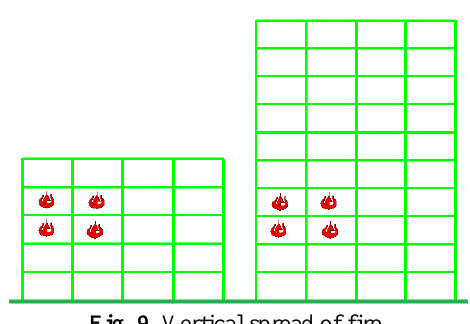
Fig. 9. Vertical spread of fire.